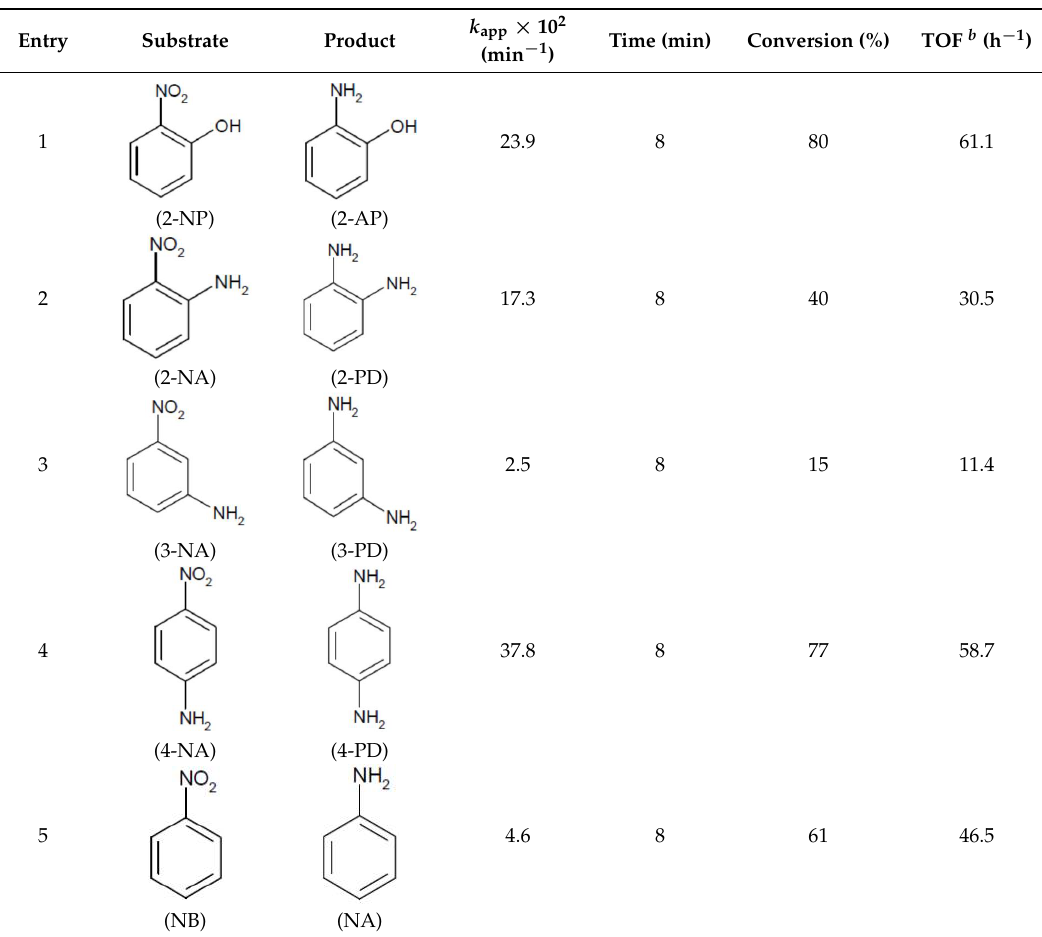
Table 3. Reduction of various substrates using AuNPs 1% tea as catalyst a .